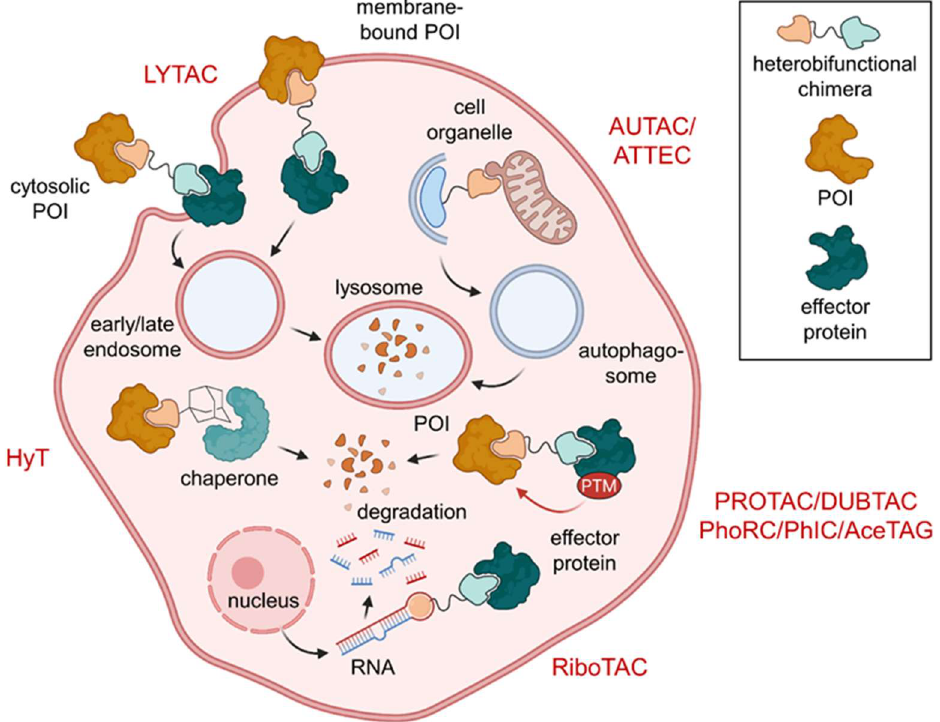
Figure 2. Overview of heterobifunctional molecules effecting PTMs. Lysosome-targeting chimeras (LYTACs) subject cytosolic or membrane-bound proteins of interest (POIs) to lysosomal degradation. Protein degradation can also be modulated by hydrophobic tags (HyT) and proteolysis-targeting chimeras (PROTACs). HyTs induce conformational changes that recruit chaperones and PROTACs effect degradation by polyubiquitination of their POI. On top of that, autophagy-targeting chimeras (AUTACs) and autophagy-tethering compounds (ATTECs) drag their POI or target organelle into the autophagosome for degradation. In addition to PROTACs, ribonuclease-targeting chimeras (RIBOTACs) mediate degradation of target hairpin RNA. Protein stabilization can be affected by deubiquitinase-targeting chimeras (DUBTACs). Phosphorylation status can be controlled using phosphorylation-inducing chimeras (PhICs) or phosphatase-recruiting chimeras (PhoRCs), while compounds based on the acetylation-tagging system (AceTAGs) can trigger POI acetylation.